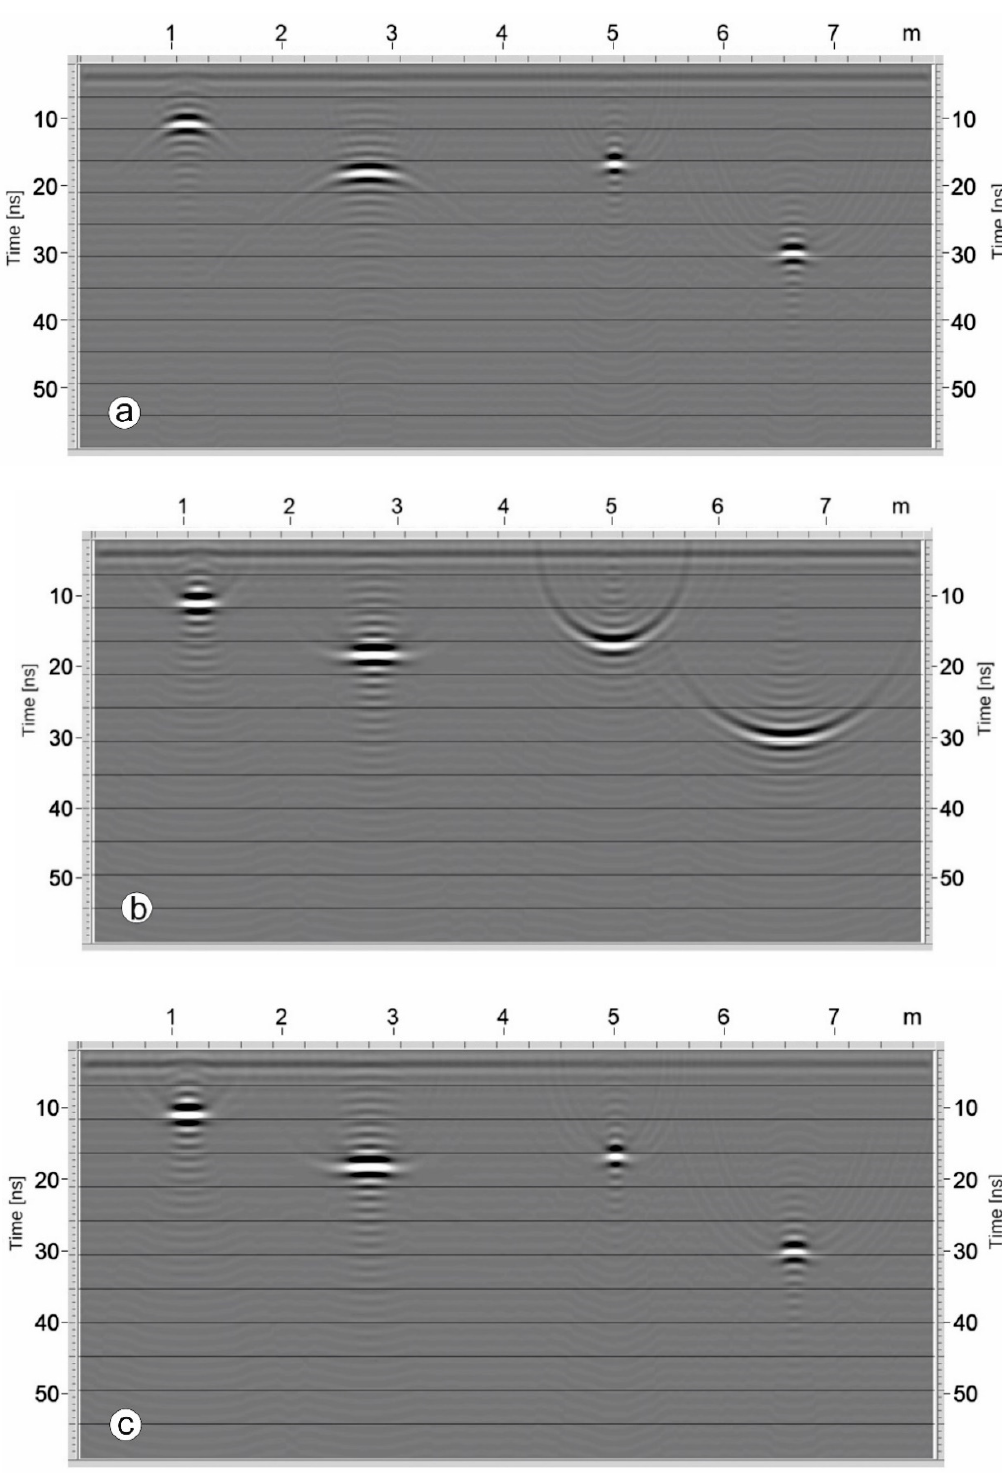
Figure 5. Migrated synthetic section using: ( a ) a constant velocity of 6.7 cm / ns; ( b ) 12.2 cm / ns; ( c ) a varying velocity field obtained by the velocity analysis in A, B, C and D. When the migration velocity is not correct, we obtain in ( a ) under-migrated data, A and B positions, and in ( b ) over-migrated data, C and D positions. Only in ( c ) are the events correctly migrated.